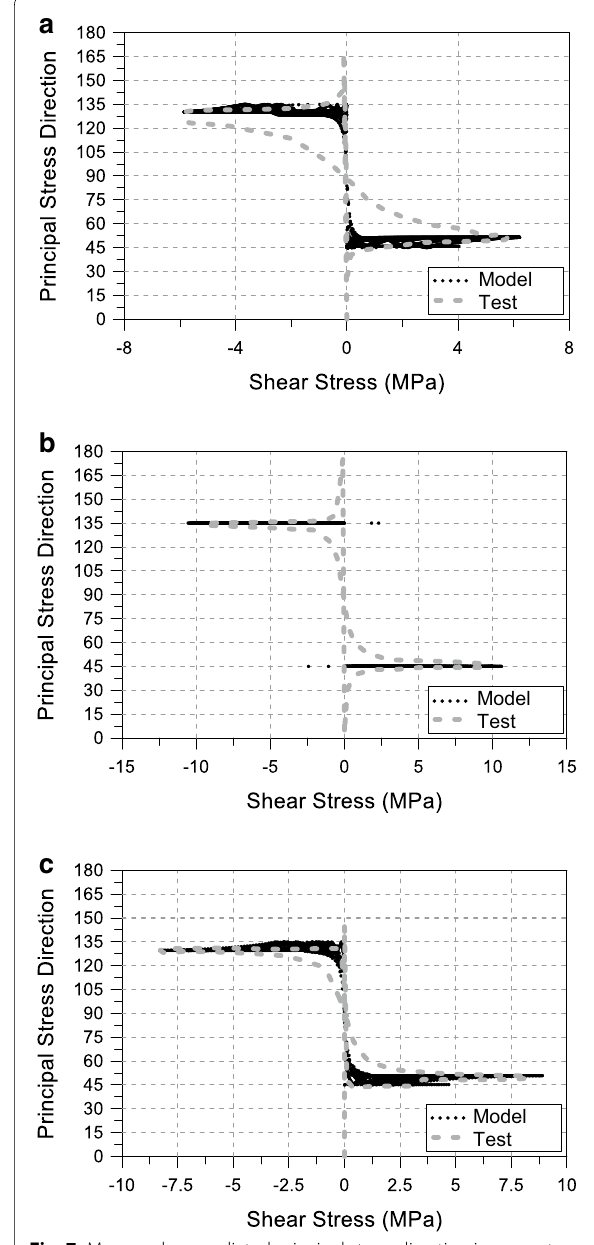
Fig. 7 Measured vs. predicted principal stress direction in concrete vs. panel shear stress: a Specimen SE8, b Specimen SE9, c Specimen